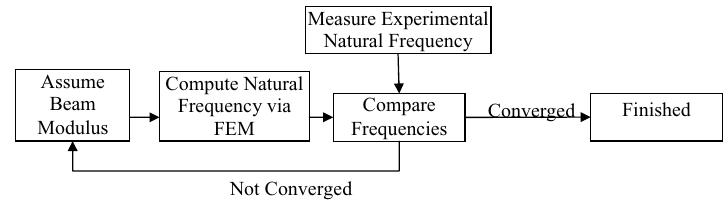
Fig. 9. Use of FEM in inverse fashion to find beam modulus.